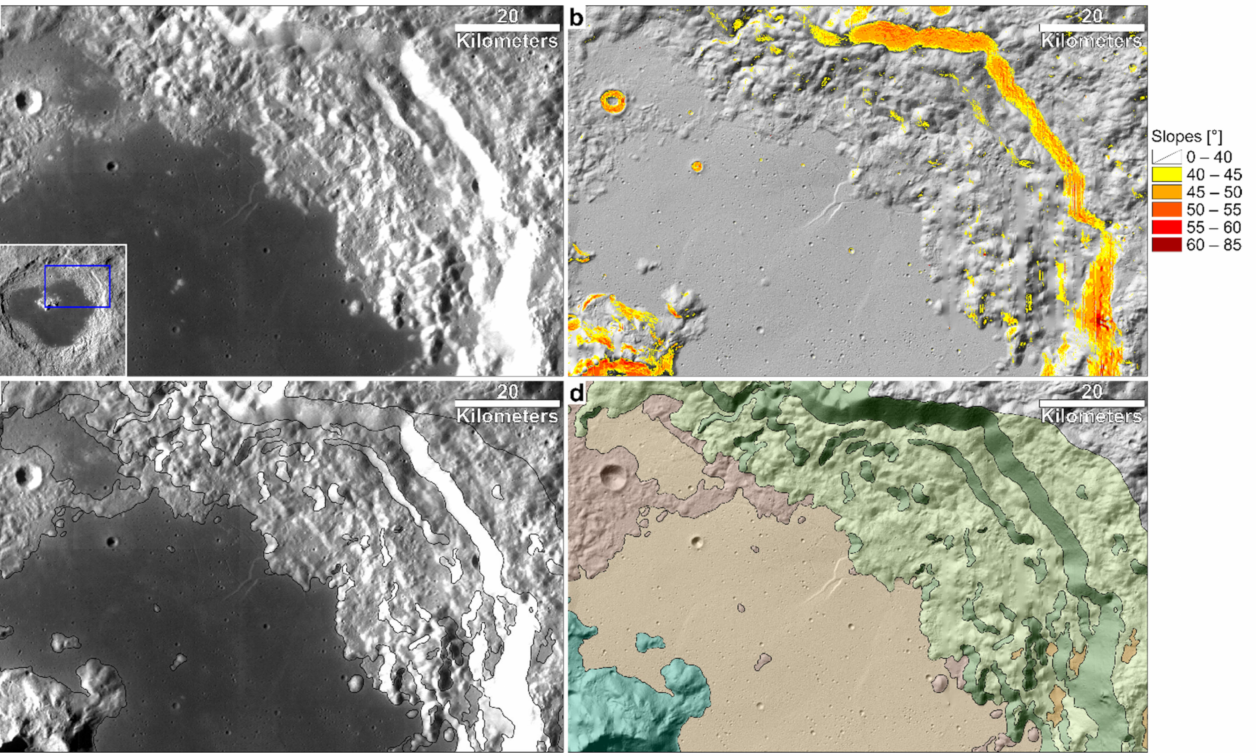
Figure 3. Detailed view of the NE portion of the Tsiolkovskiy crater. ( a ) Lunar Reconnaissance Orbiter Wide Angle Camera (LROC-WAC) mosaic [30]; ( b ) DEM-derived hillshade superimposed by the surface slope map highlighting scarps with slopes > 40 ◦ ; ( c ) LROC-WAC basemap with geologic contact linework; and ( d ) geologic units on top of the DEM-derived hillshade.